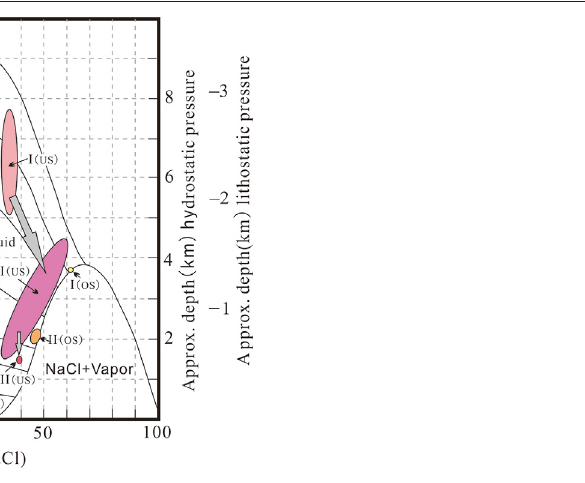
Frontiers in Earth Science |